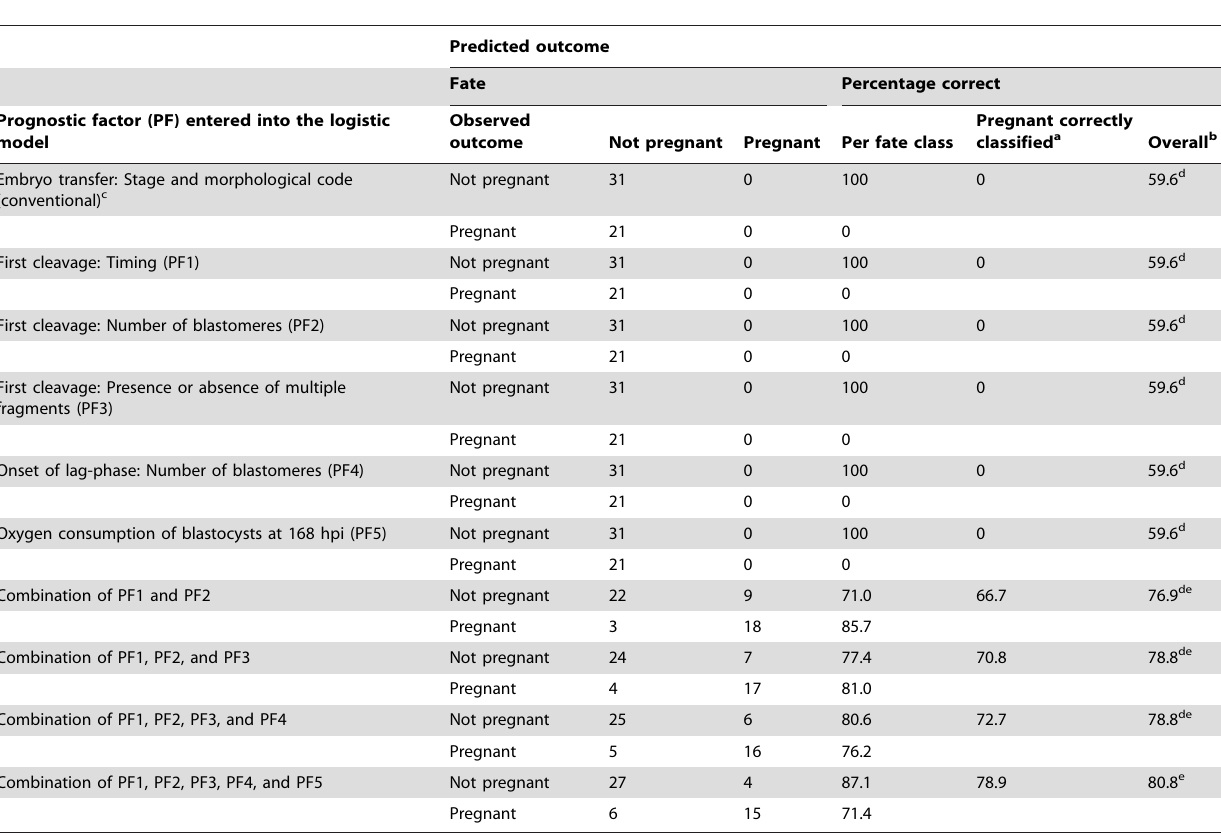
Table 1. Classification matrices for selected regression models illustrating the prediction accuracy of variables examined either individually or in